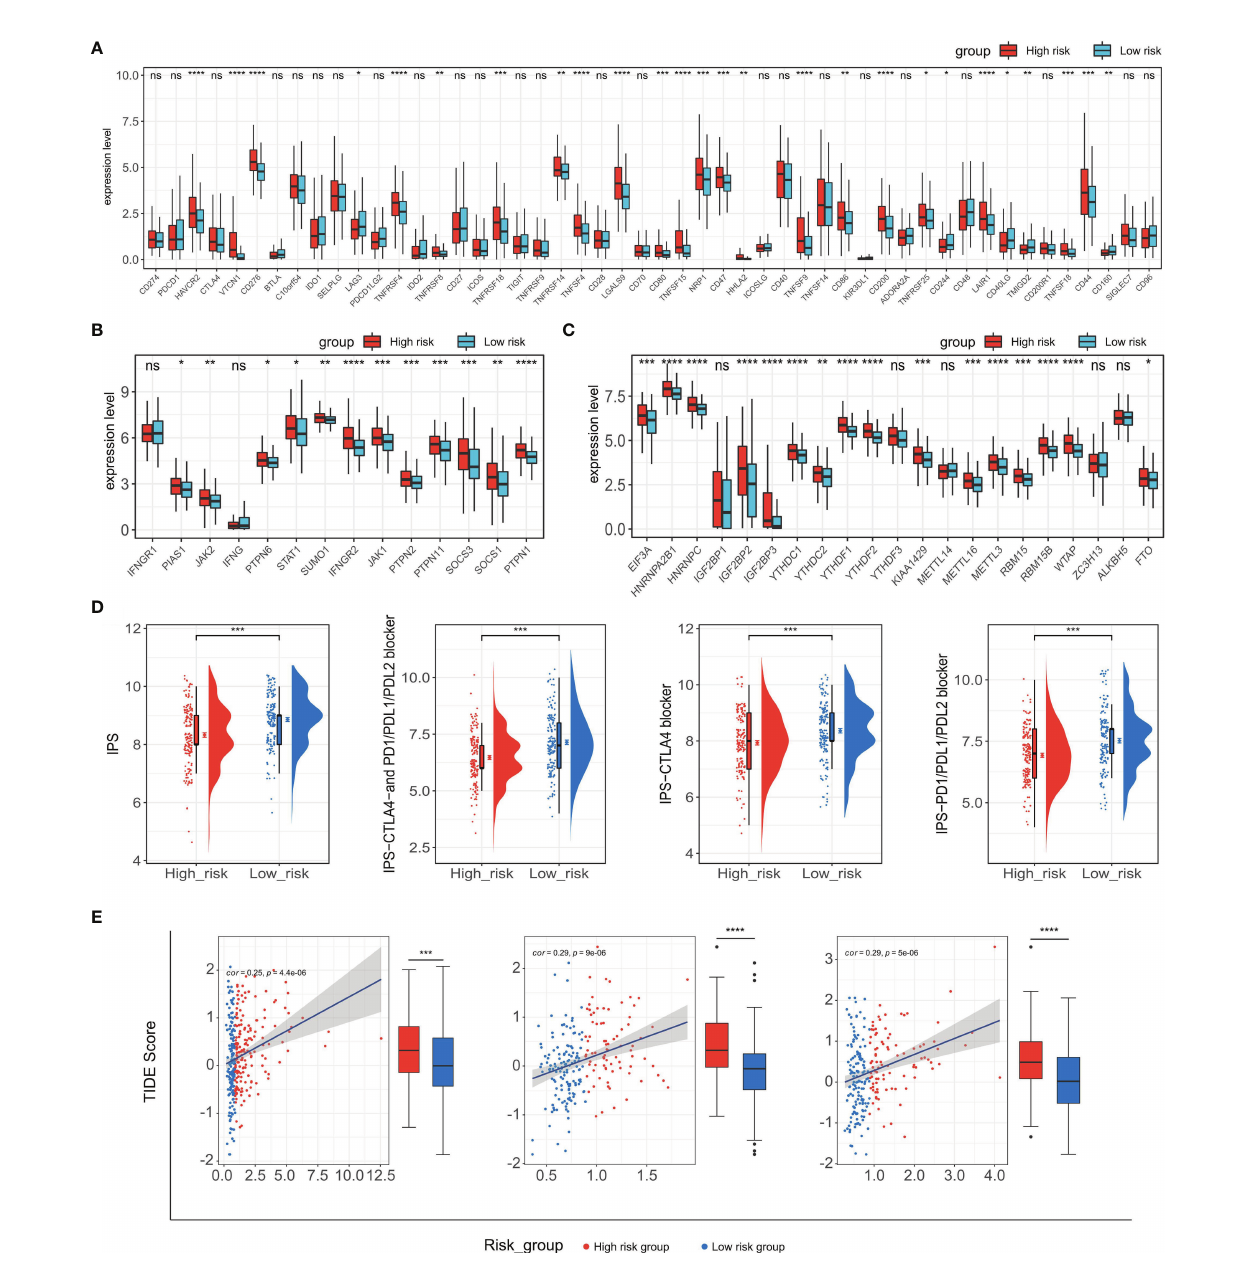
FIGURE 9 | Application of the TIPRGPI model for immunotherapy prediction. (A – C) Expression of immune checkpoint molecules (A) , IFN-gamma pathway-related markers (B) , and m6A regulators (C) in low- and high-risk groups. (D) The relationship between TIPRGPI and IPS. (E) Distribution of TIDE scores in the TCGA-LIHC, GSE14520, and ICGC-LIRI-JP datasets. *P < 0.05, **P < 0.01, ***P < 0.001, ****P < 0.0001, ns, not signi fi